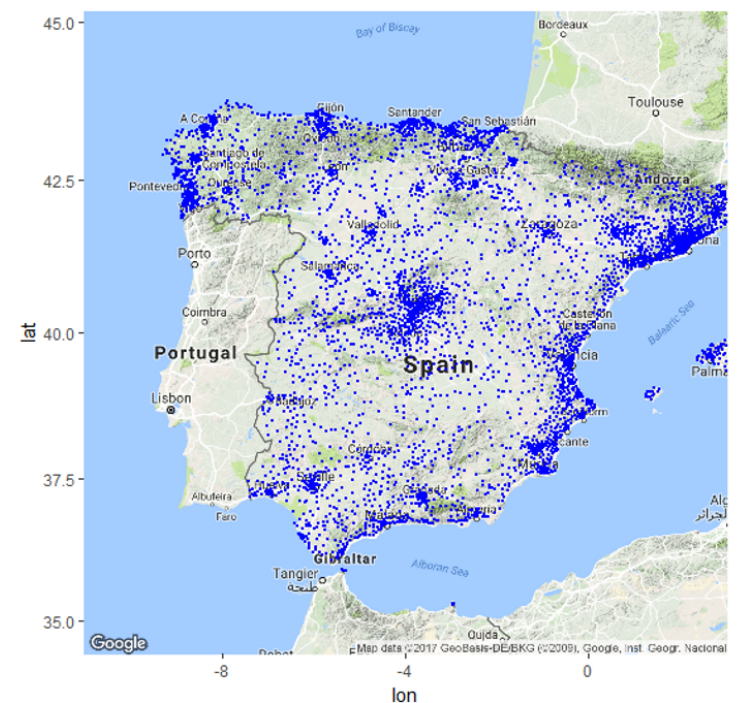
Figure 1. Geographical distribution of portfolio dwellings throughout